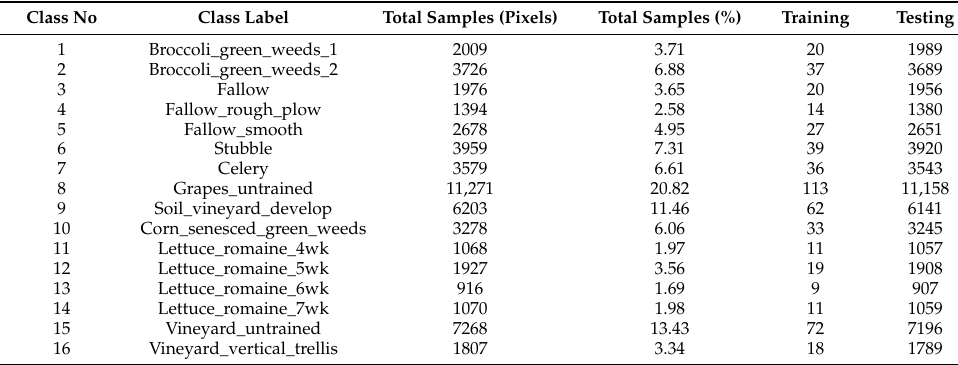
Table 3. Per Class information for the SA